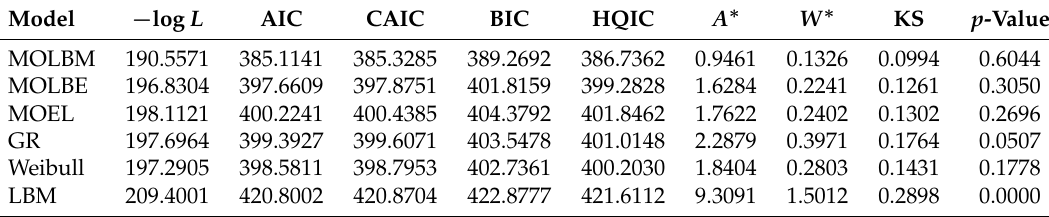
Table 12 indicates the − log L , AIC, CAIC, BIC, HQIC, A ∗ , W ∗ , KS and p -value of the considered models. Table 12. Some criteria and goodness of fit measures for Data set 3.